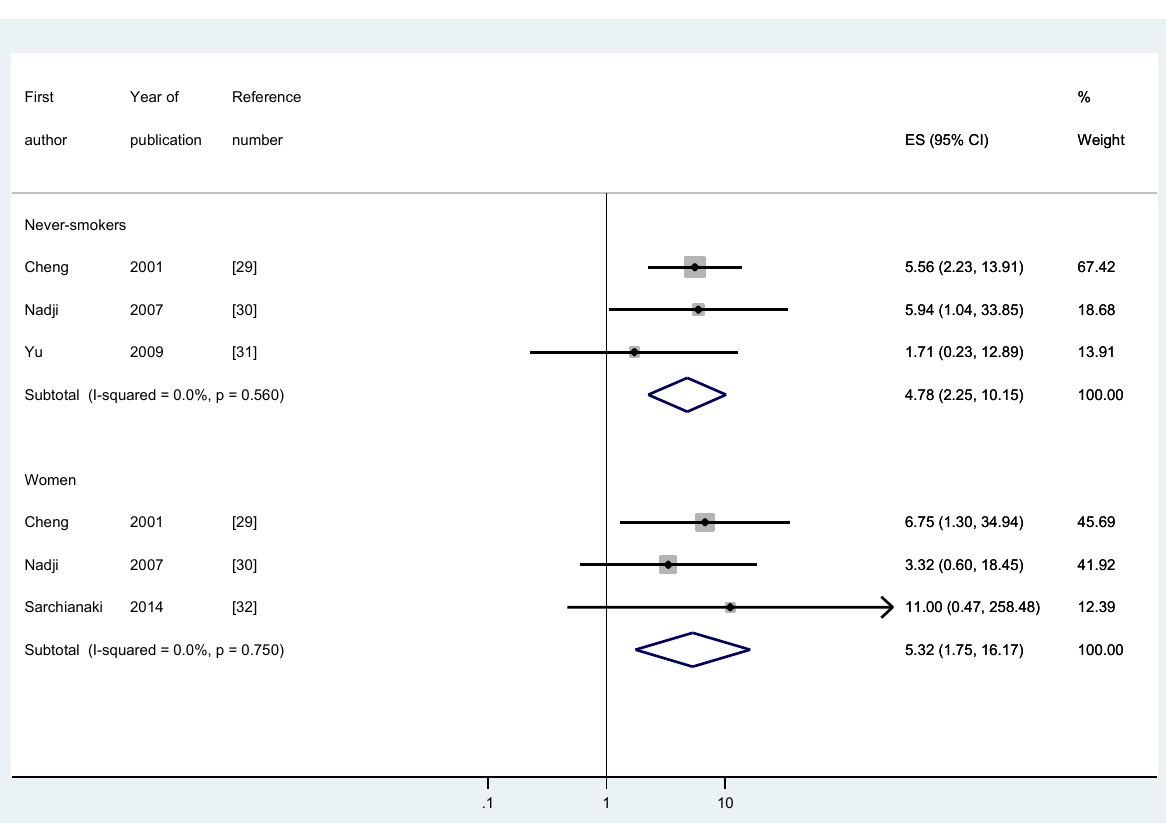
Table 2. Human papillomavirus detection and risk of lung cancer in women and never-smokers Type